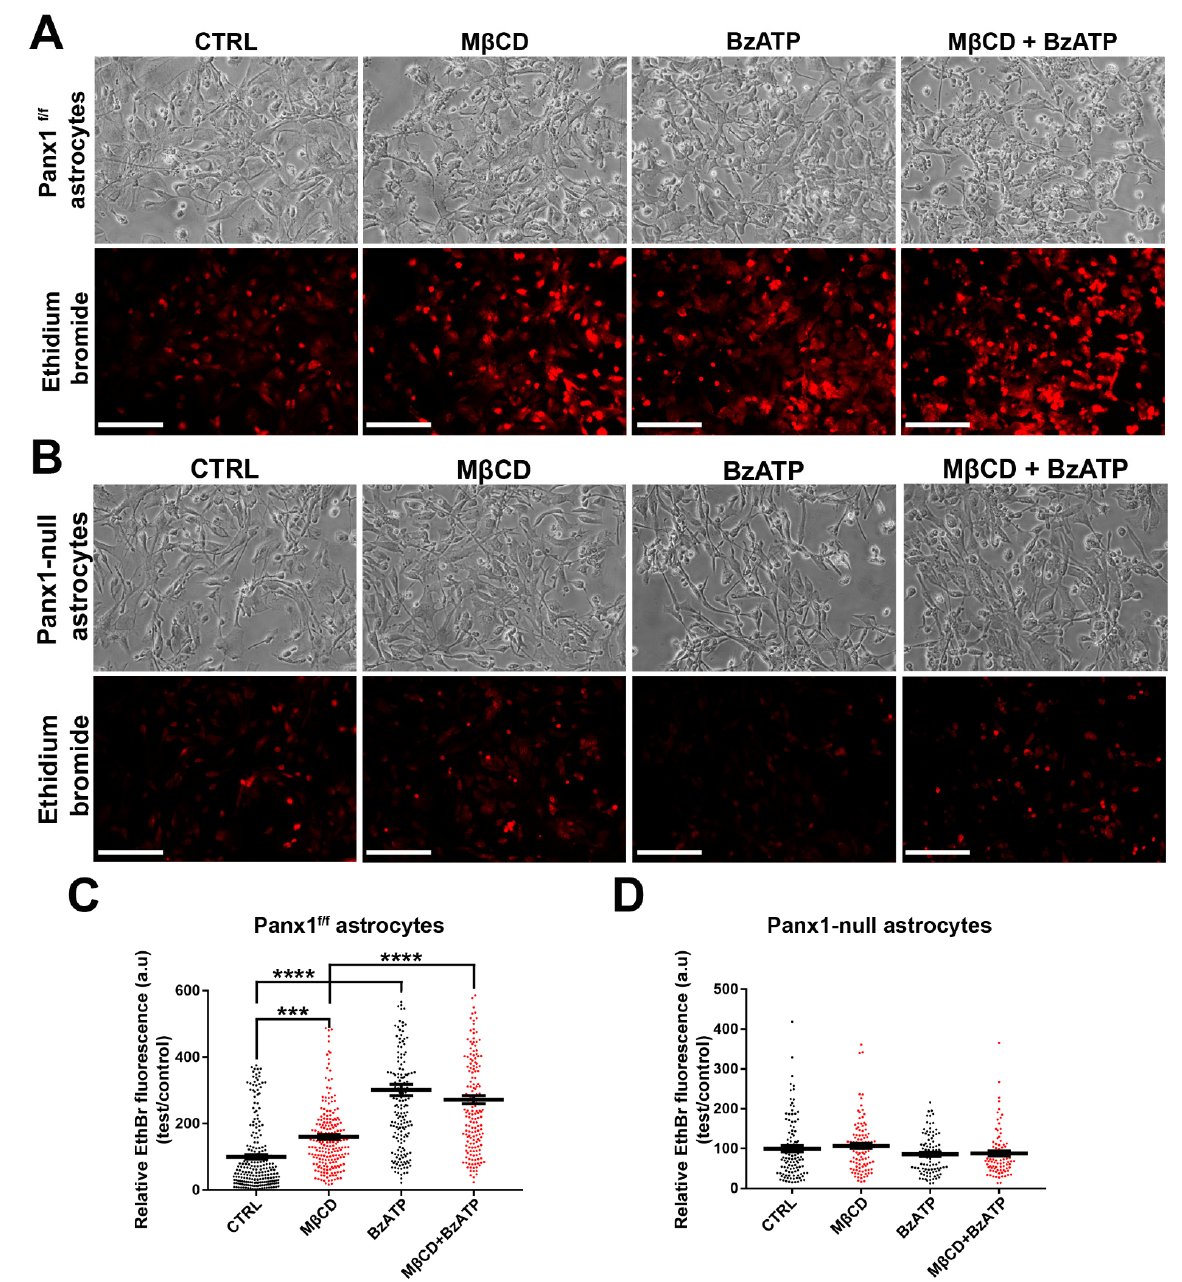
Figure 8. Cholesterol depletion enhances dye uptake through Panx1 channels in astrocytes. ( A ) Fluorescence micrographs of intracellular EthBr in normal conditions (CTRL) and after treatment with M β CD, BzATP, or with both drugs. Scale bar: 100 µm. ( B ) EthBr uptake in Panx1-null astrocytes induced by M β CD with and without BzATP. Scale bar: 100 µm. ( C ) Histograms showing relative EthBr uptake compared to controls for treatment with M β CD alone or together with BzATP. ( D ) Mean ± SEM values of the relative EthBr fluorescence intensity obtained from Panx1-null astrocytes after M β CD, 100 µM BzATP, and M β CD with BzATP treatment. Values were normalized to those obtained under control conditions. In ( C , D ), each bar on the graphs represents mean value of relative EthBr fluorescence changes recorded from all cells present in a field of view obtained from 3–5 independent experiments. p values obtained from ANOVA test followed by Dunnett’s test. *** p < 0.001, **** p <